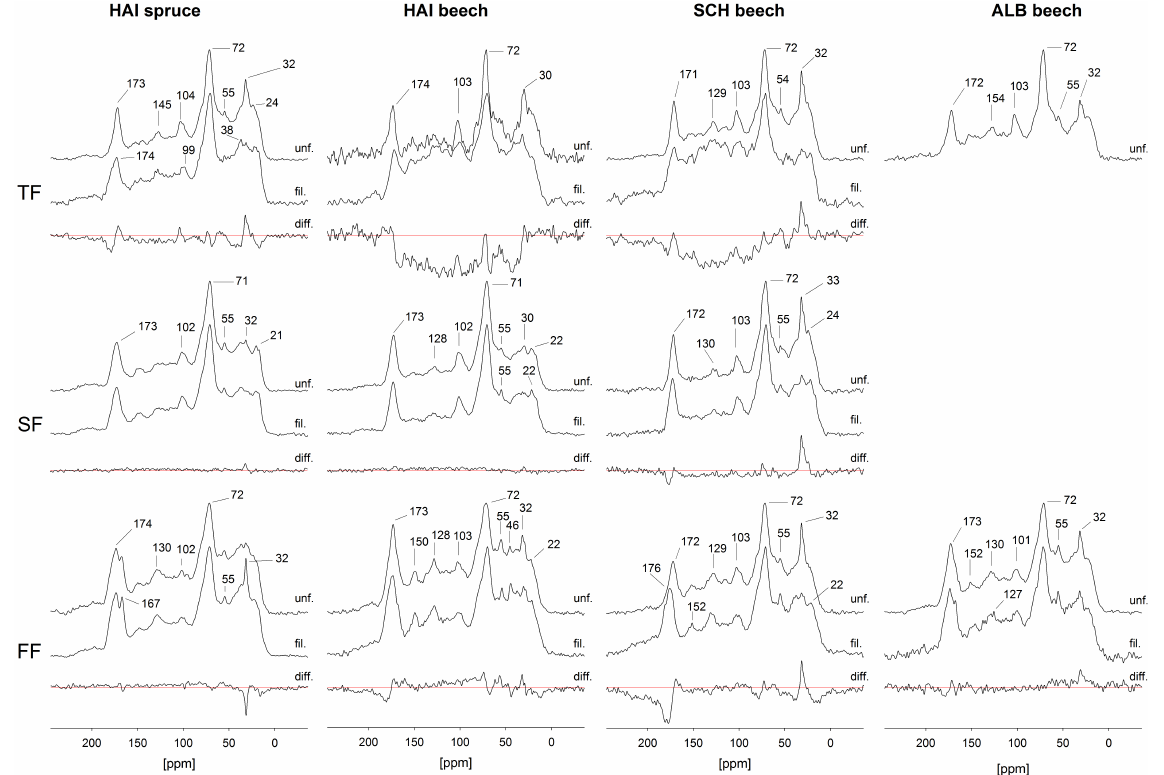
Figure 1. Solid-state CPMAS 13 C NMR spectra obtained from filtered (fil.) and unfiltered (unf.) forest ecosystem water samples as well as calculated difference spectra (diff.) of both fractions; TF stands for throughfall, SF for stemflow, FF for forest floor leachate, ALB for Schwäbische Alb, HAI for Hainich–Dün and SCH for Schorfheide–Chorin; red lines indicate zero level within difference